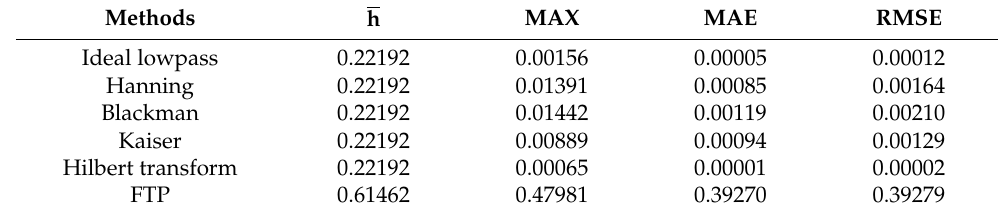
Figure 6. Reconstruction errors. ( a ) MP based on Ideal low-pass; ( b ) MP based on Hanning; ( c ) MP based on Blackman; ( d ) MP based on Kaiser; ( e ) MP based on Hilbert transform; ( f ) FTP. Table 2. Reconstruction errors.